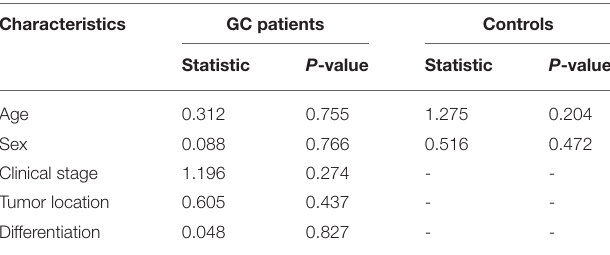
TABLE 3 | The relationships about clinicopathological characteristics of participants between training cohort and validation cohort.